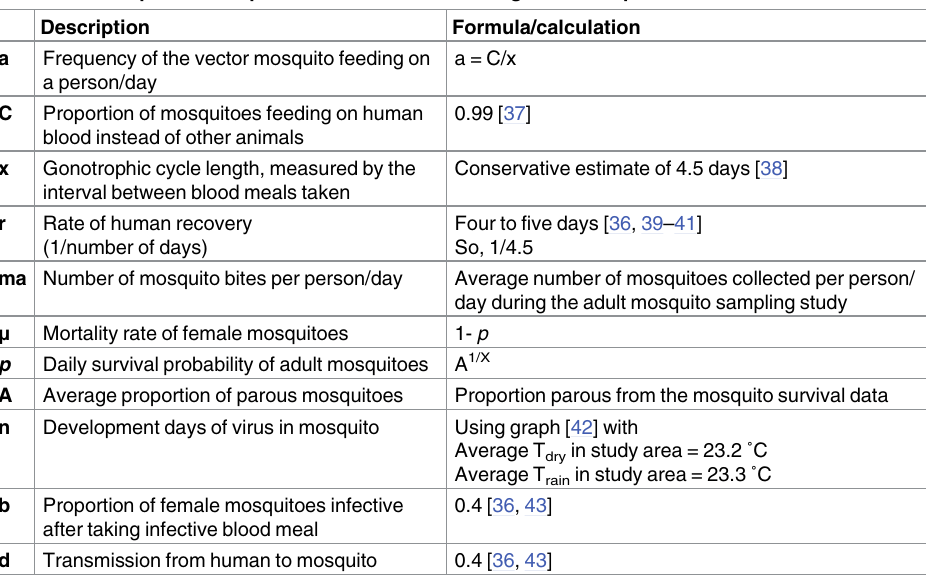
Table 1. Description of the parameters used for the dengue basic reproductive number